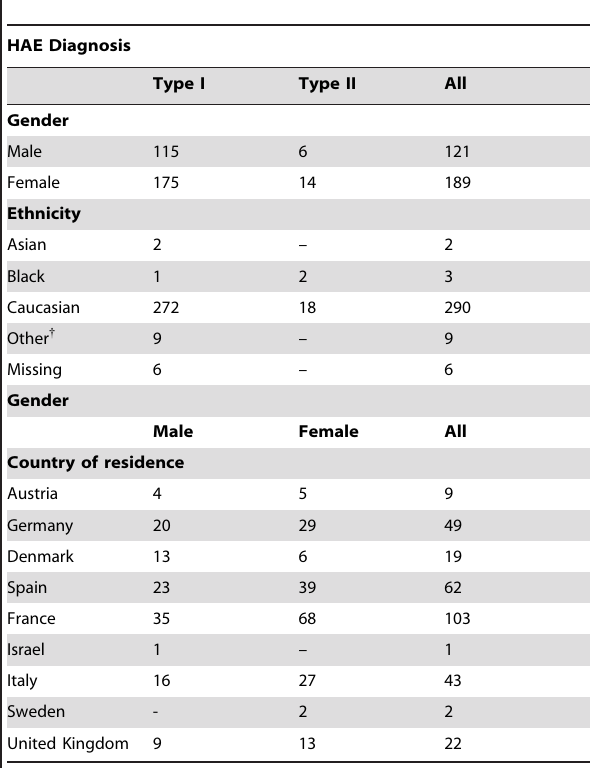
Table 1. Patient demographics.